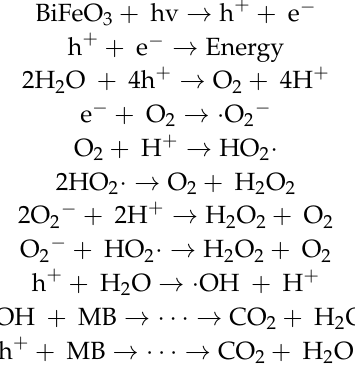
Figure 7. ( a ) P—T curves for the 3D BFO/graphene composites and ( b ) the degradation rate of MB dyes from different materials under visible light irradiation.